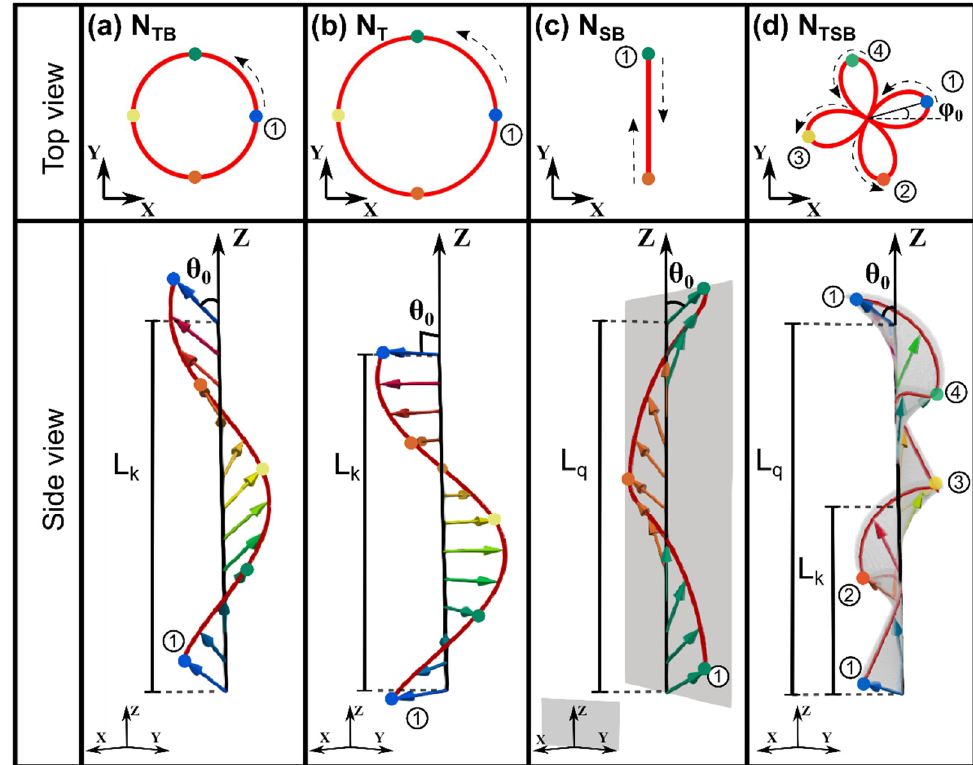
Figure 2. Motifs of 1-D periodically modulated states of a uniaxial nematic elastic continuum; top and side views. The arrows represent the nematic director n . L k and L q denote, respectively, the repetition lengths of the rotation and vibration modes of the director. ( a ) The twist–bend state, N TB . The director n has a fixed projection, cos θ 0 , along the modulation axis Z . ( b ) The pure twist state, N T . The director n is perpendicular to the modulation axis Z . ( c ) The splay–bend state, N SB . The director n is shown to remain on the Y-Z plane, with its projection along the Y axis oscillating with amplitude sin θ 0 . ( d ) A state showing twist, splay and bend deformation ( N TSB ) with the oscillation repeat length L q chosen to be twice the rotation repeat length L k . The angle ϕ 0 represents a constant phase difference between the rotation and oscillation modes.